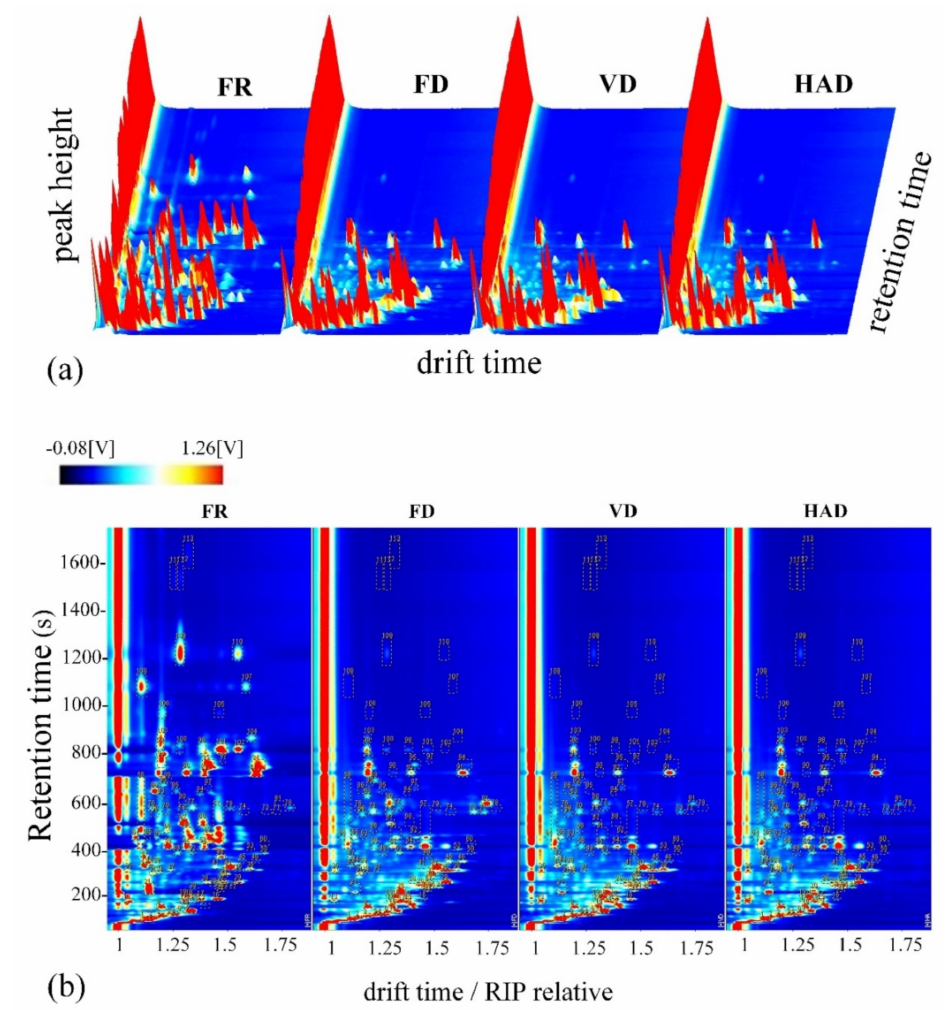
Figure 1. Topographic plots of fresh (FR) and dried AMR treated by using different drying methods. ( a ) Three-dimensional topographic plots. ( b ) Two-dimensional topographic plots. The data are represented by two-dimensional topographical visualizations in Figure